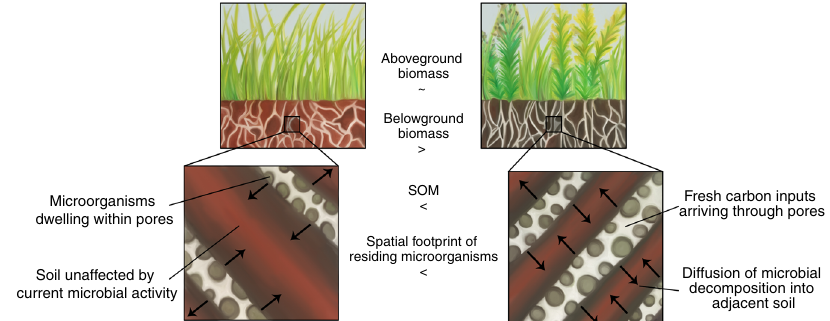
Fig. 5 Microbial footprint de fi nes the soil volume available for C protection. Schematic representation of the effect that the abundance of 30 – 150 µ m pores has on the size of the spatial footprint of microorganisms residing in such pores in perennial switchgrass monoculture and biodiverse native vegetation